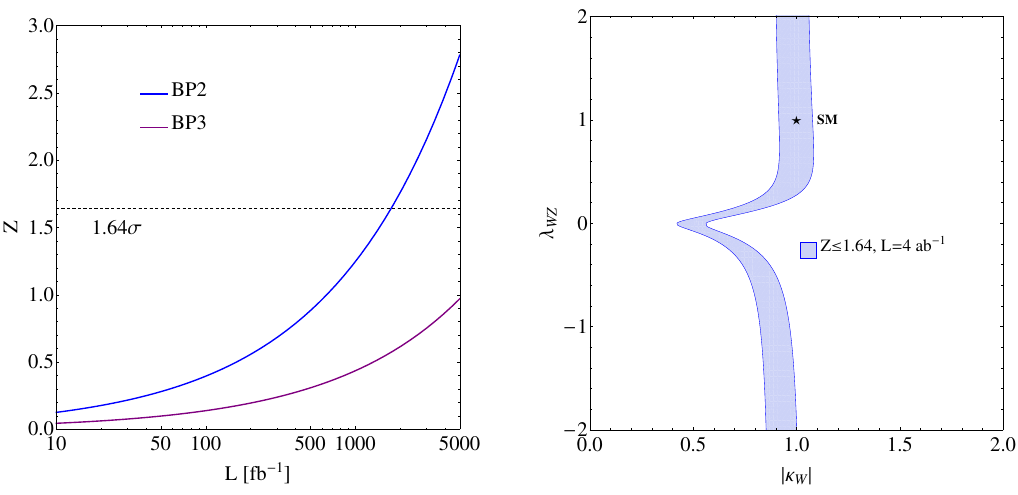
Figure 7 . Power to discriminate (cid:21) WZ in the ‘ (cid:6) ‘ (cid:6) ‘ (cid:7) jj channel for scheme A at the 500-GeV ILC with the beam polarization P ( e (cid:0) ; e + ) = ( scenarios from the SM scenario (BP1). Right: region in the assuming an integrated luminosity of 4 ab (cid:0) 1